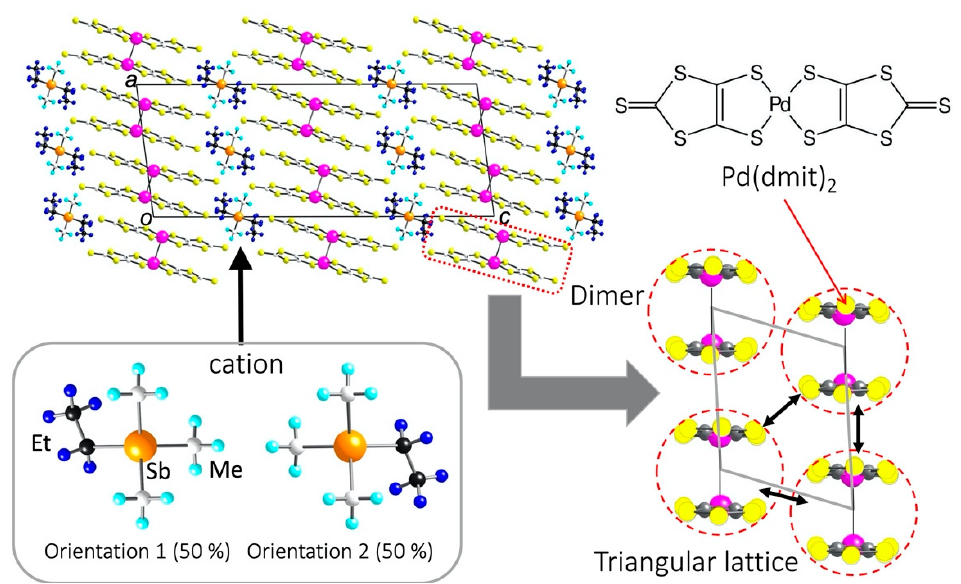
Figure 1. Crystal structure of β′ -EtMe 3 Sb[Pd(dmit) 2 ] 2 . The cation on the two-fold axis shows an orientational disorder.